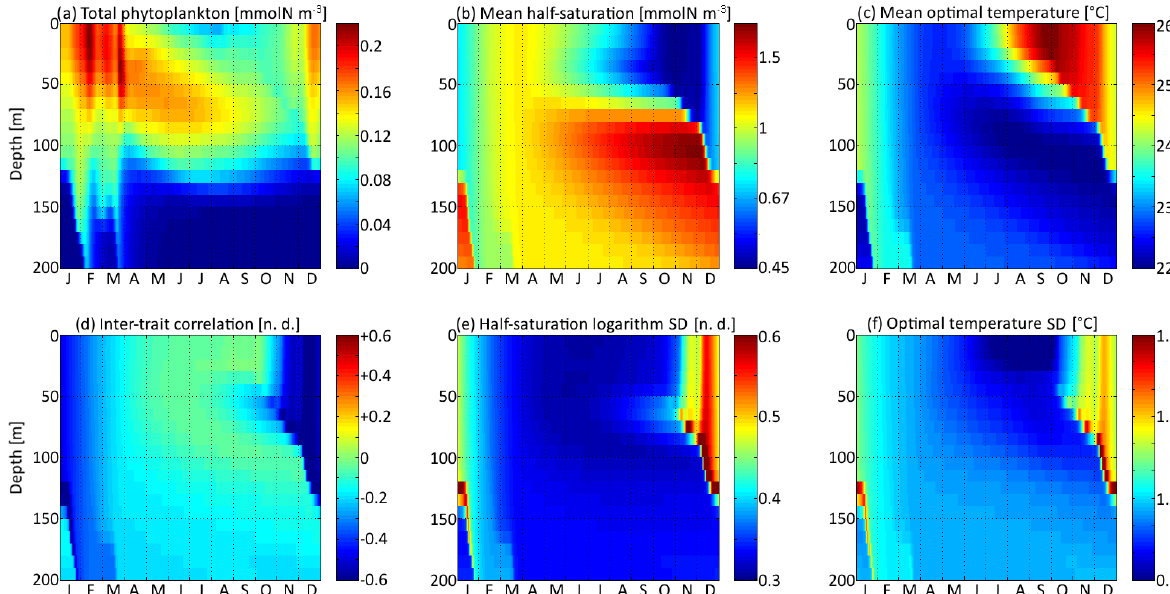
Figure 5. Distribution in depth and time of trait distribution moments for ν x = 0 . 001 and ν y = 0 . 01 ◦ C 2 : (a) phytoplankton concentration, (b) (geometric) mean half-saturation, (c) optimal temperature, (d) inter-trait correlation, (e) half-saturation logarithm standard deviation, and (f) optimal temperature standard deviation. For readability, the mean value of trait x is transformed into a nitrogen concentration in (b) . To speak properly and in contrast to other means present in this study, the mean half-saturation is a geometric mean, not an arithmetic mean.